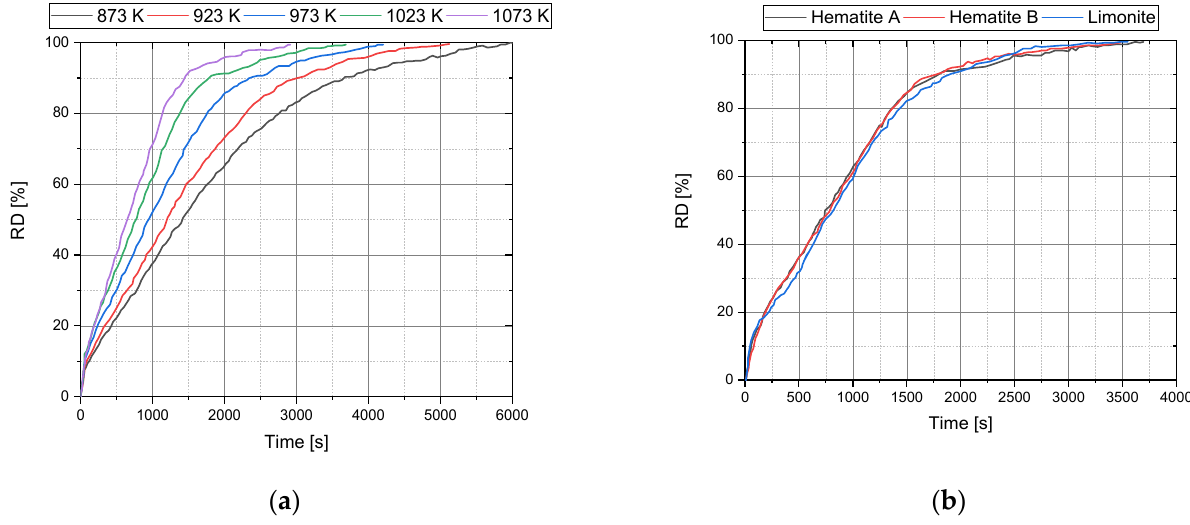
Figure 1. Reduction progress of hematite iron ore at different temperatures ( a ) and hematite and limonite-based ore at 1023 K ( b ). Adapted with permission from Ref. [19]. Copyright 2020, Elsevier